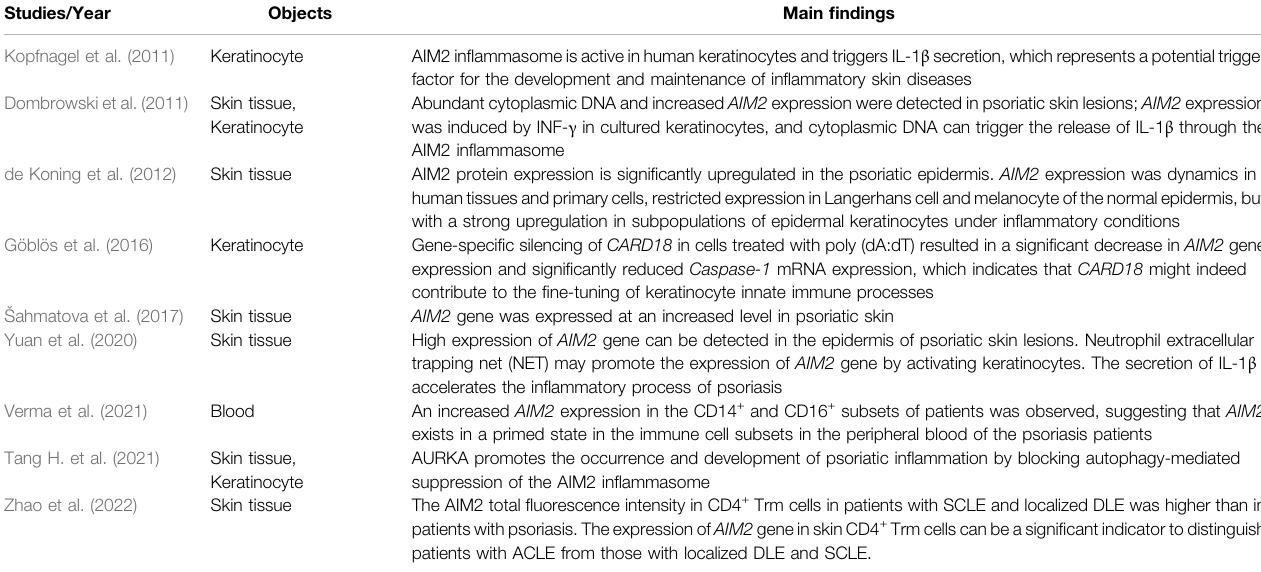
TABLE 1 | Roles of AIM2 gene and AIM2 in fl ammasome in the pathogenesis of psoriasis.